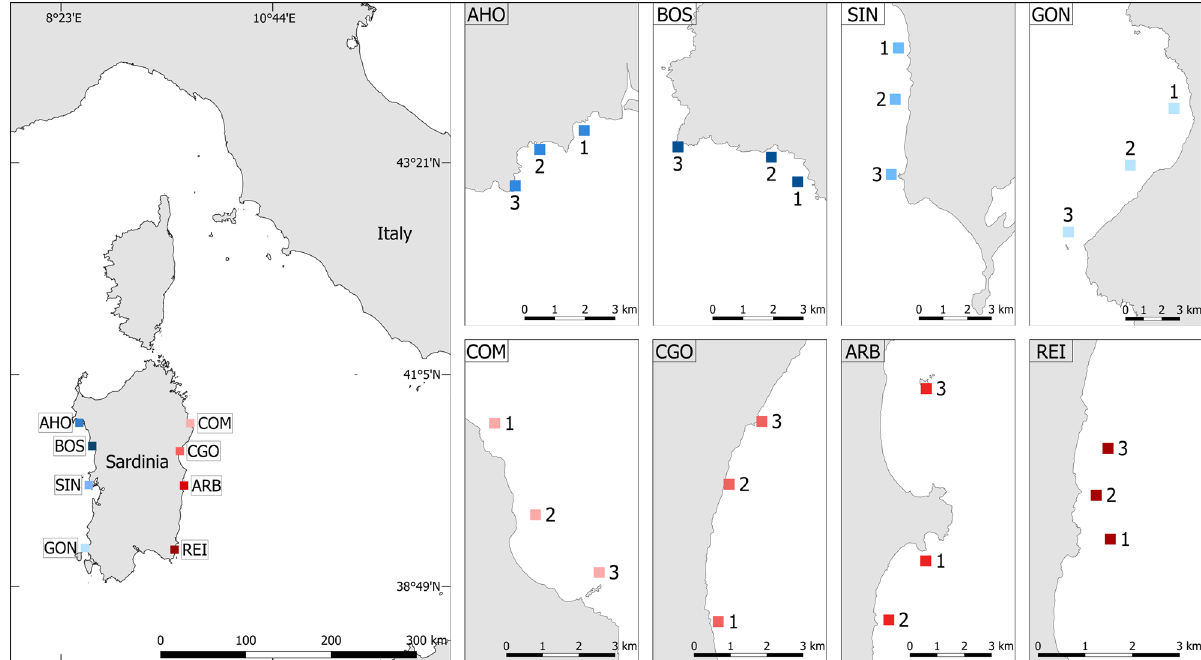
Figure 6. Study locations and areas along the Sardinian coasts. Left-hand map shows locations on the west (in blue) and east (in red) coasts: AHO Alghero, BOS Bosa, SIN Penisola del Sinis, GON Gonnesa, COM Capo Comino, CGO Cala Gonone, ARB Arbatax, REI Costa Rei. Right-hand inset maps show location of each study area within each location. Map produced with QGIS 3.16